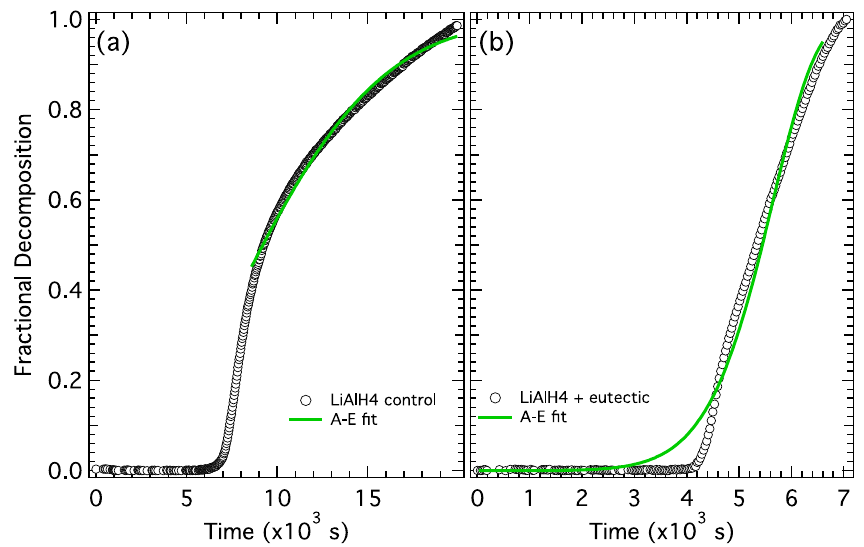
Figure 6. Fractional decomposition from step 1 for ( a ) LiAlH 4 control and ( b ) LiAlH 4 + Li-KBH 4 eutectic. Table 3. Fit parameters from an A-E fit to the first step of desorption (fractional decomposition) of LiAlH 4 (control) and LiAlH 4 + eutectic (electrolyte).